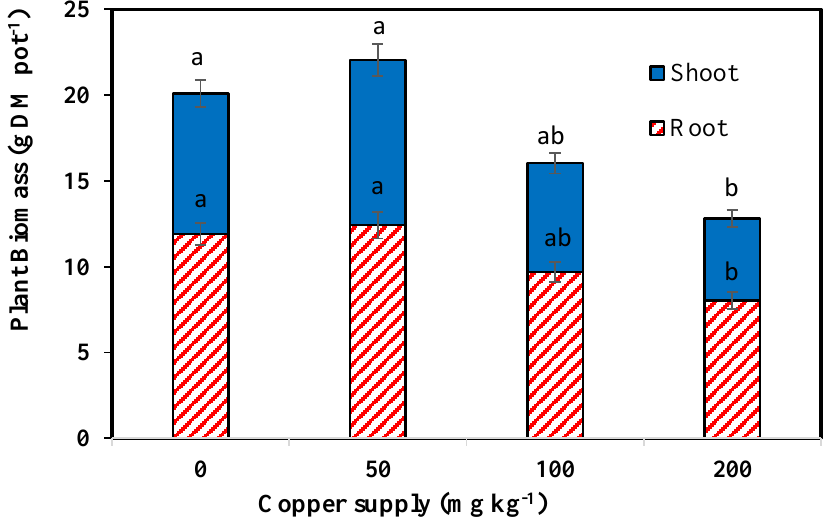
Figure 2. Dried biomass of Zea mays grown in contaminated soil with soil with 0, 50, 100 and 200 mg kg − 1 copper after 42 days. Mean values that do not share a letter are significantly different at p = 0.05 (mean ± S.E.; n = 3).